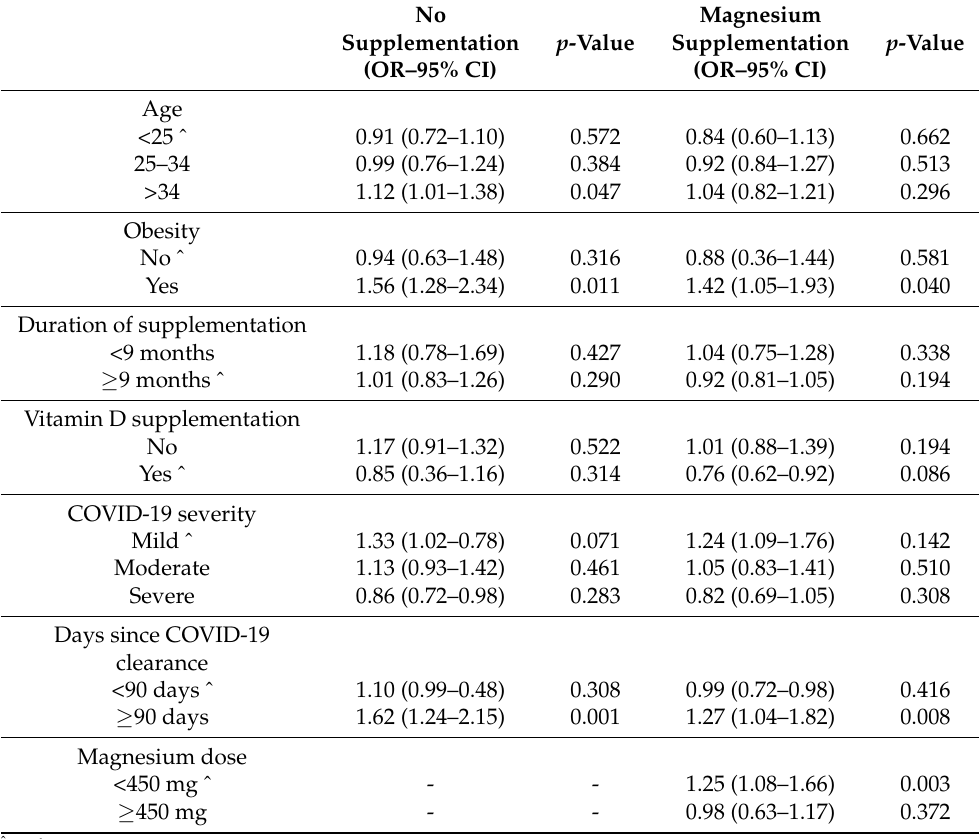
Figure 2. Box-plot of maternal immune response after SARS-CoV-2 infection clearance, measured during labor and stratified by nutritional supplementation with magnesium-based supplements and magnesium dose. Data analyzed by Kruskal–Wallis test. Table 4. Analysis of risk factors for weak immune response (<500 SARS-CoV-2 anti-RBD) of pregnant women based on micronutrient supplementation during